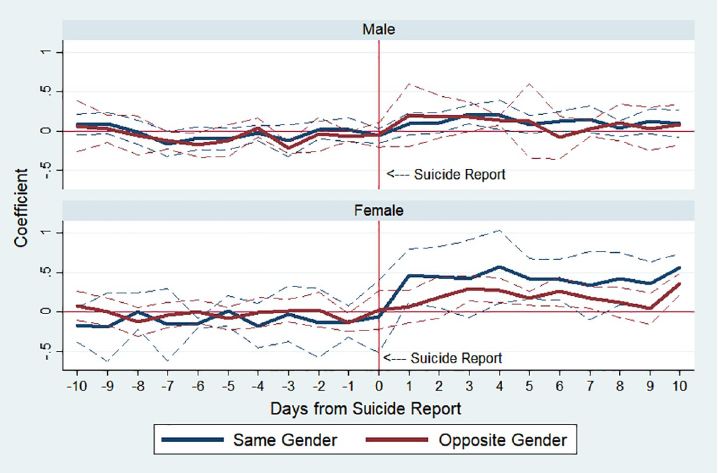
Fig 5. Estimated changes in total suicides by gender before and after media reports on celebrity suicide. Note: “Same Gender” refers to celebrity suicides of the same gender, while “Opposite Gender” refers to those of the opposite gender. For example, the effect of female celebrity suicides on the female sample is the blue line denoted as “Same Gender” while the effect of male celebrity suicides on the female sample is the red line denoted as “Opposite Gender.” The y -axis indicates an approximate percent change in public suicide by corresponding day, which is the estimated β k in Eq (1). The dotted lines indicate 95% confidence